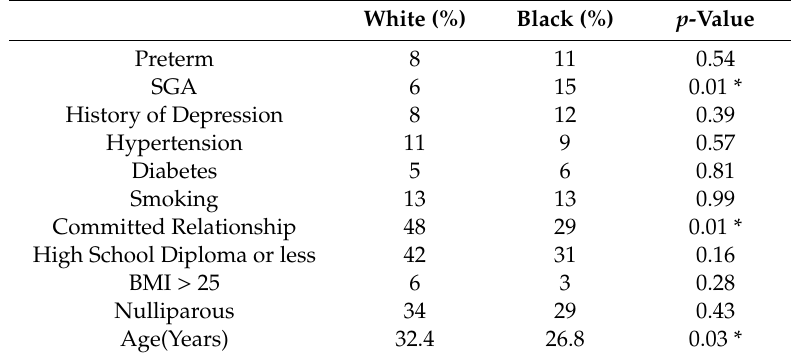
Table 2. Racial di ff erences in baseline characteristics of stratified sample ( n = 200).